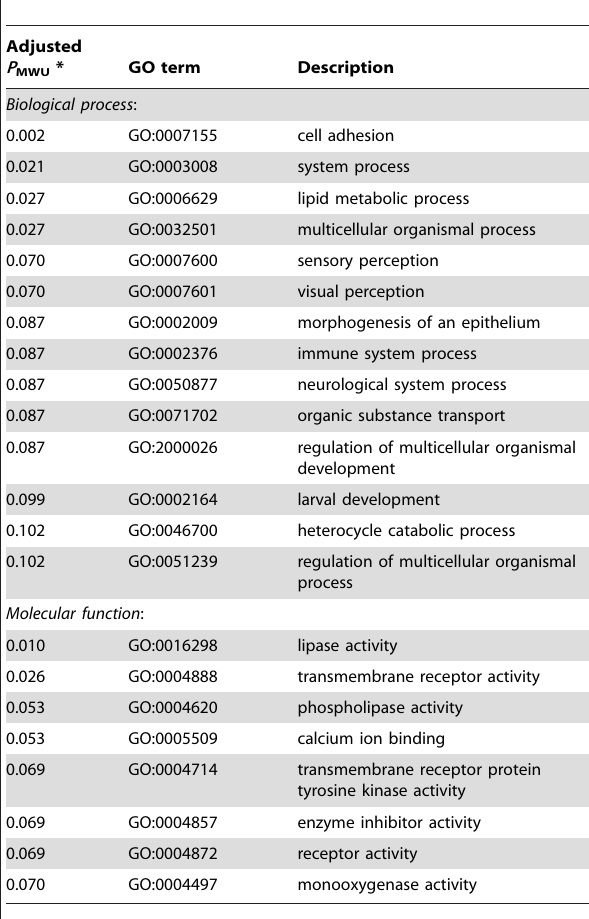
Table 3. List of GO categories most strongly enriched for orthologs with elevated d N /d S